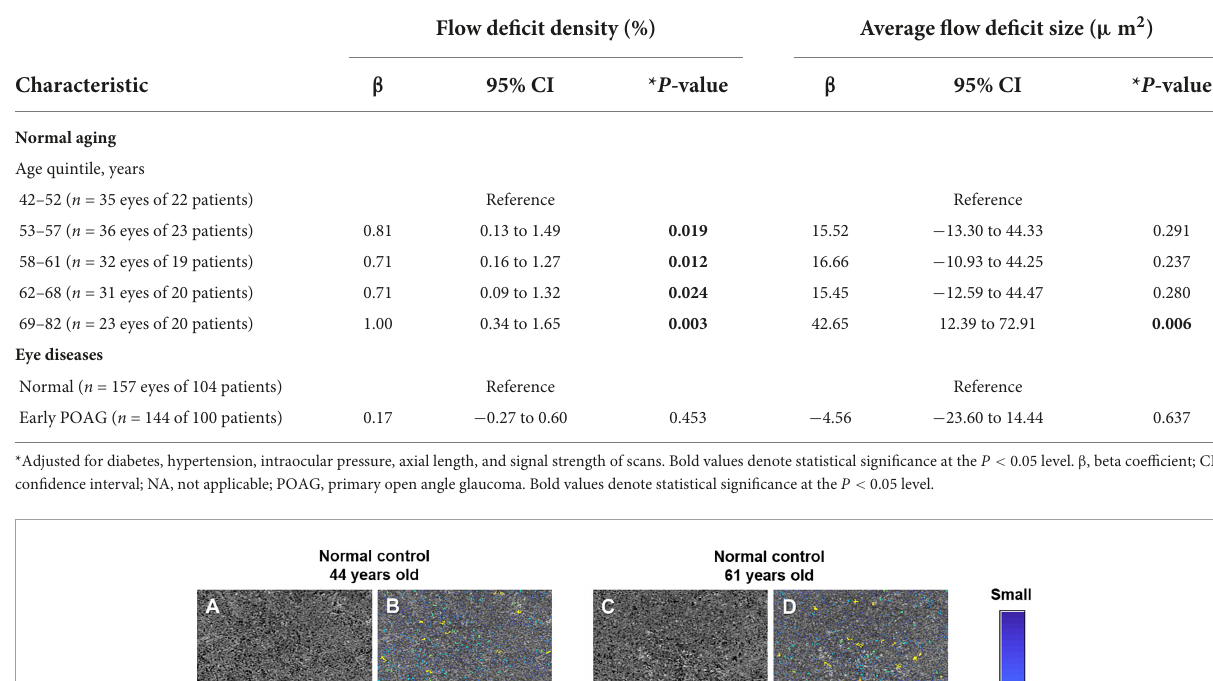
TABLE 2 Multivariable linear regression modeling of the association between normal aging, primary open angle glaucoma and choriocapillaris flow deficits.